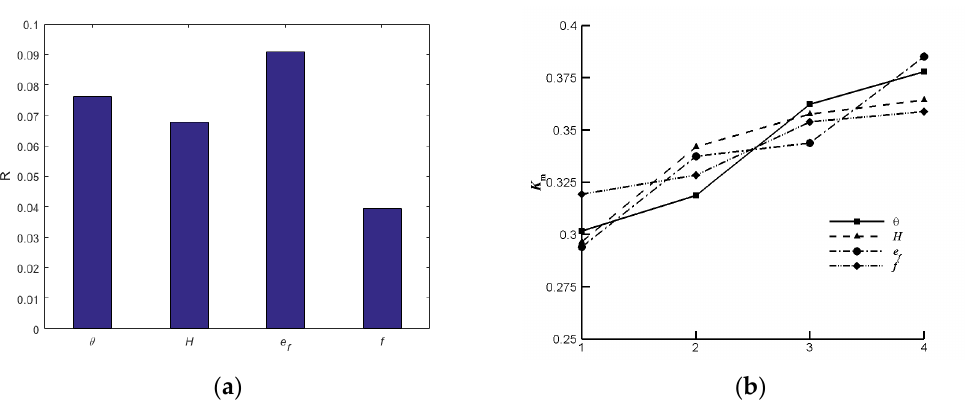
Figure 16. Range and influence of different parameters on Km . ( a ) Range. ( b ) Influence trend.